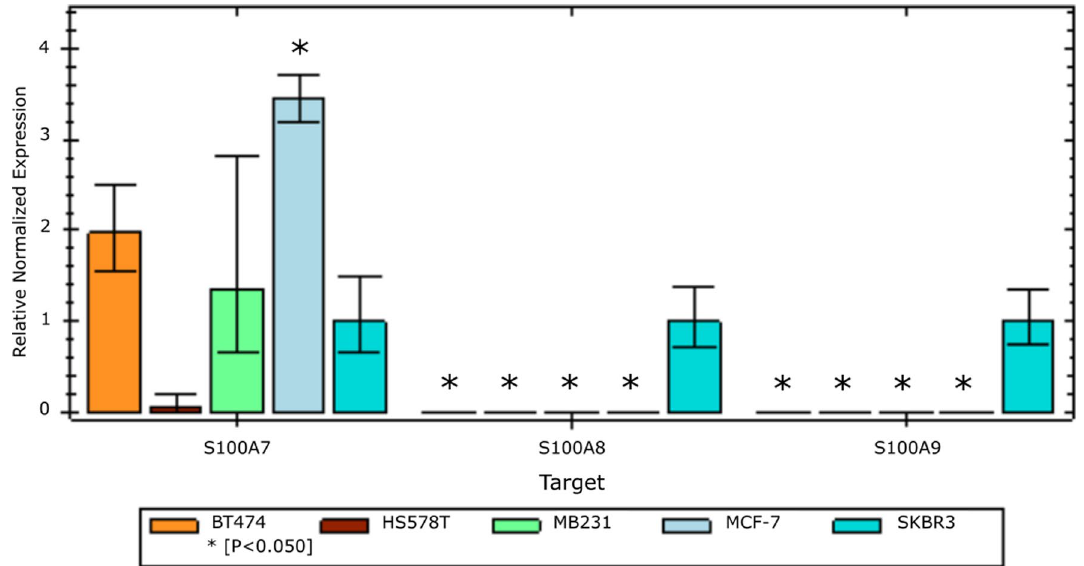
Fig. 5 LP2 gene expression in breast cancer cell lines. RT-qPCR bar graphs of relative normalized RNA expression of LP2 genes in BrC cell lines. Gene expression from three LP2 genes (S100A7, A8, A9) were examined in MCF-7 (Luminal A, light blue), BT474 (Luminal B, orange), SKBR3 (HER2-overexpressing, turquoise), HS578T (TN claudin-low, brown), and MB231 (TN claudin-low, green). The error bars show standard error of the mean. Three independent experiments are shown. * indicates p < 0.050 compared to